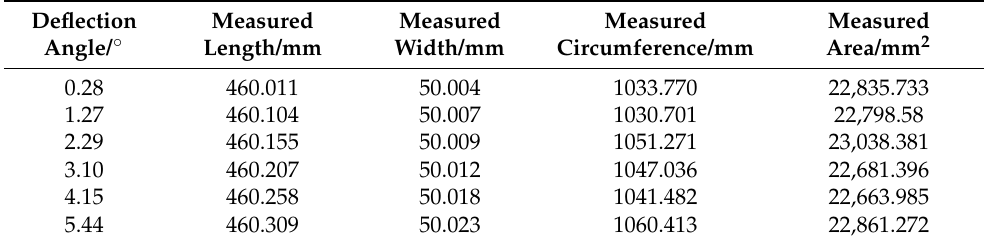
Table 1. Dimensional measurement of dimension lumber in different conveying deflection angles.